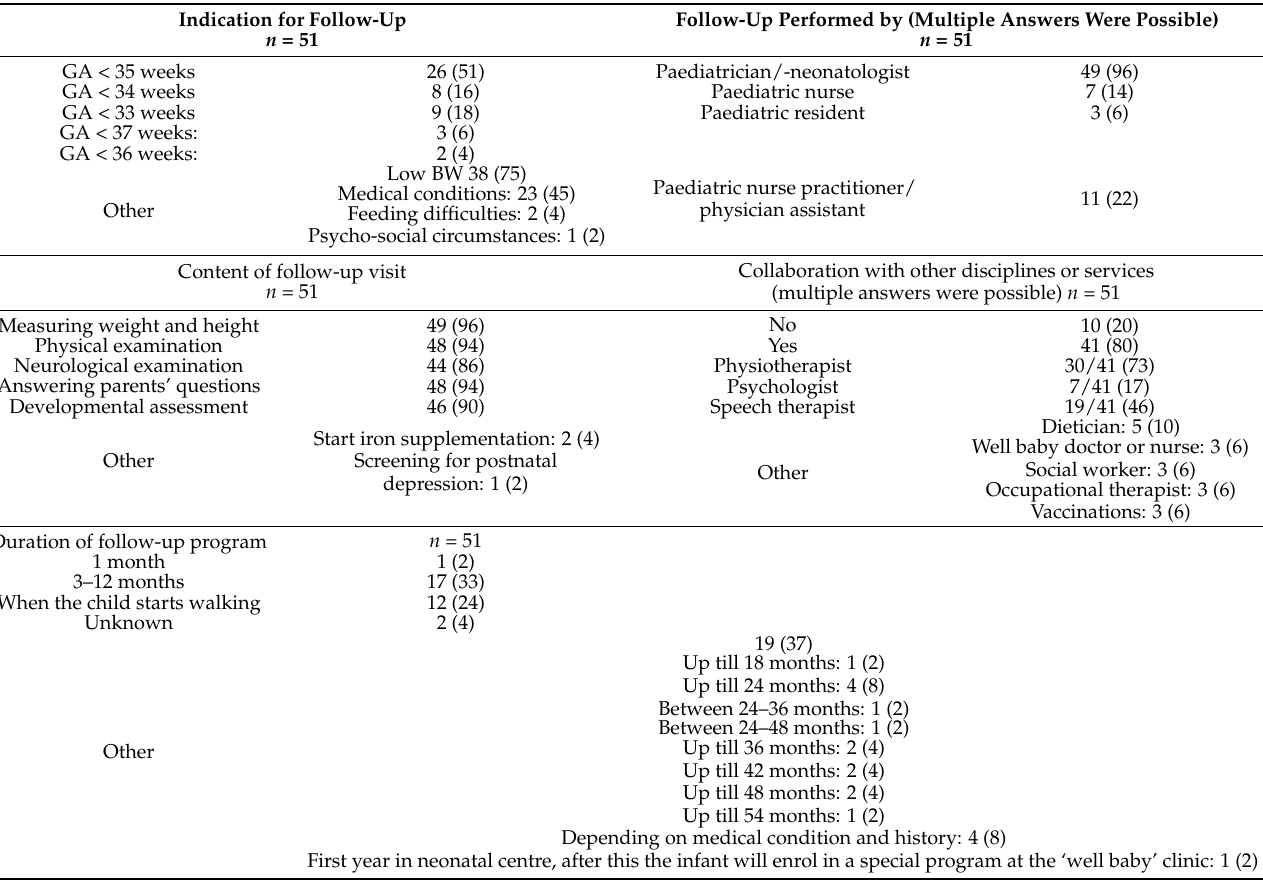
Table 3. Indication for follow-up, content, and duration of follow-up programs in MLPT